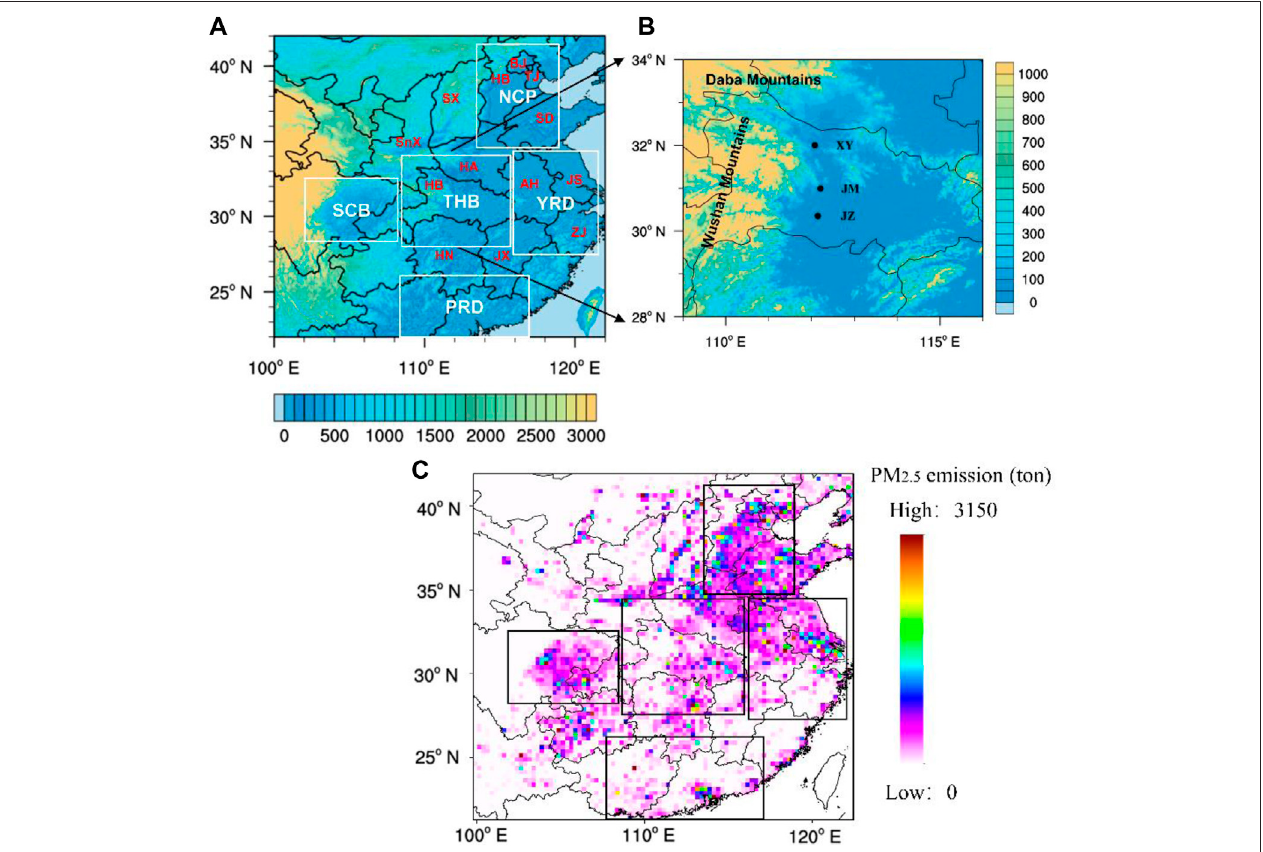
FIGURE 1 | (A) Terrain height (m) of central and eastern China with the locations of provinces. The regions of NCP, PRD, YRD, SCB, and THB are outlined approximately with a white frame. (B) Terrain height (m) of the THB and surrounding areas with the location of cities of XY, JM, and JZ (black dots). (C) Distribution of PM 2.5 emissions from anthropogenic sources in central and eastern China (2017 winter